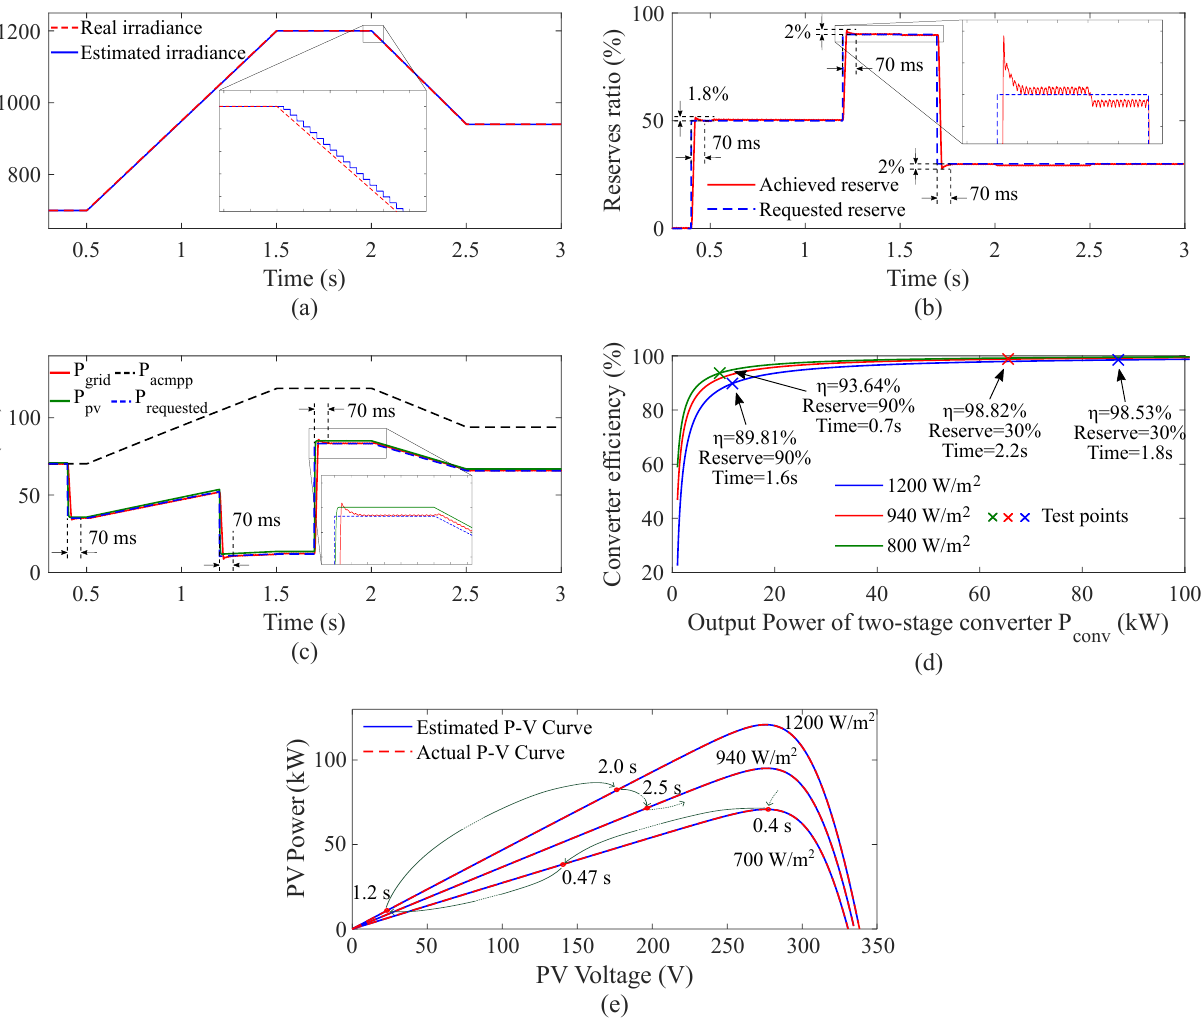
Figure 20. Simulation results: ( a ) Irradiance evolution, ( b ) power reserves evolution, ( c ) power evolution, ( d ) two-stage converter efficiency, and ( e ) estimated and actual P-V curve. Figure 20d illustrates the converter efficiency obtained by simulation. The blue, red and green lines are obtained from Equation (16), while test points are calculated from the simulation at different reserve commands (30%, 90%) and irradiance levels (800 W/m 2 , 940 W/m 2 , 1200 W/m 2 ). The near-perfect match of test points to the estimated lines can be observed in this figure. Figure 20e shows the comparison of the estimated (blue line) and the actual P-V curve (dashed red line) at different irradiance levels (700 W/m 2 , 940 W/m 2 , 1200 W/m 2 ). As